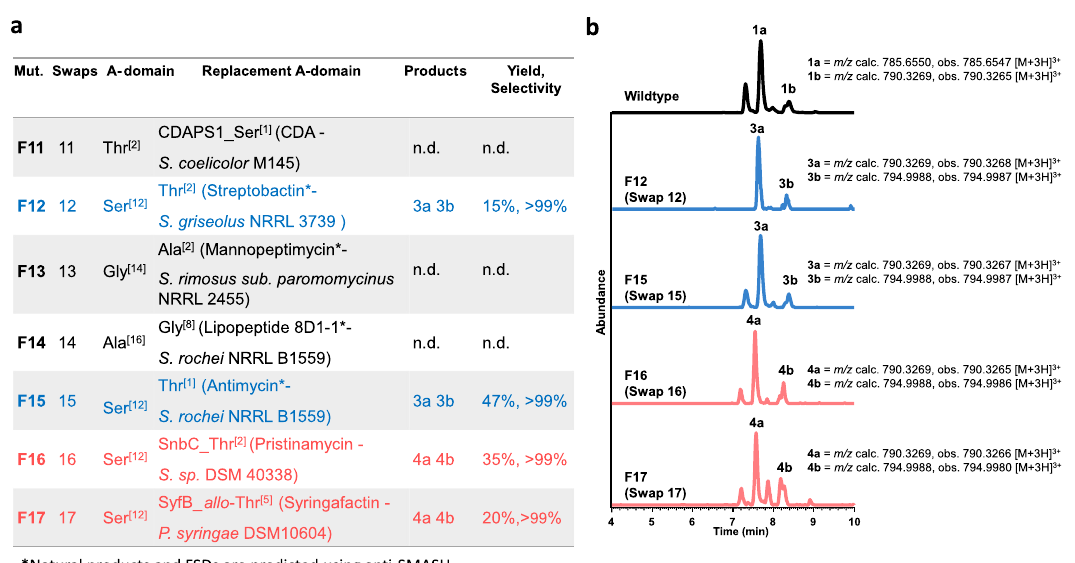
Fig. 5 Overview and extracted ion chromatographs (EIC) of enduracidins a and b analogues from LC-HRMS analysis of the additional subdomain swap mutants (F11-17) generated in this study. a List of additional swap mutants constructed using FSDs from various NRPSs to demonstrate the broad applicability of this method. b Combined EIC of enduracidins a and b analogues from LC-HRMS analysis of extracts from additional S. fungicidicus strains (F12 and F15-17) used in this study (normalized to 100%). The product for Swap 16 had a retention time consistent with the incorporation of allo -Thr. Source data for yield and selectivity are provided with this paper. *Natural products and FSDs are predicted using